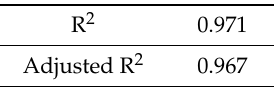
Table 3. Goodness-of-fit statistic. Dynamic modulus. Table 4. Analysis of variance. Dynamic modulus.